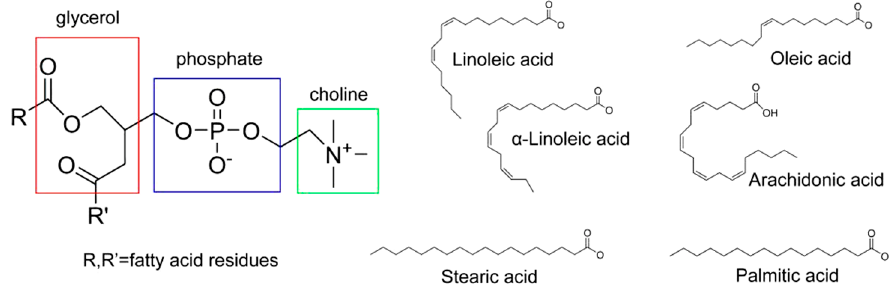
Figure 2. Main structure of the phosphatidylcholine, representative phosphatidylcholine groups and main fatty acid residues.